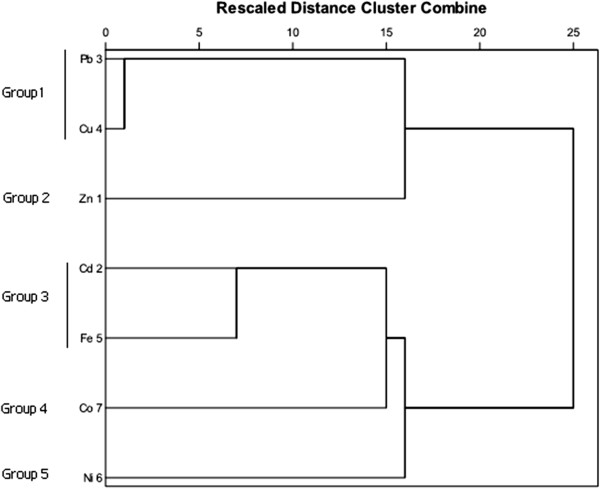
Dendrogram of heavy metal concentrations of water samples.